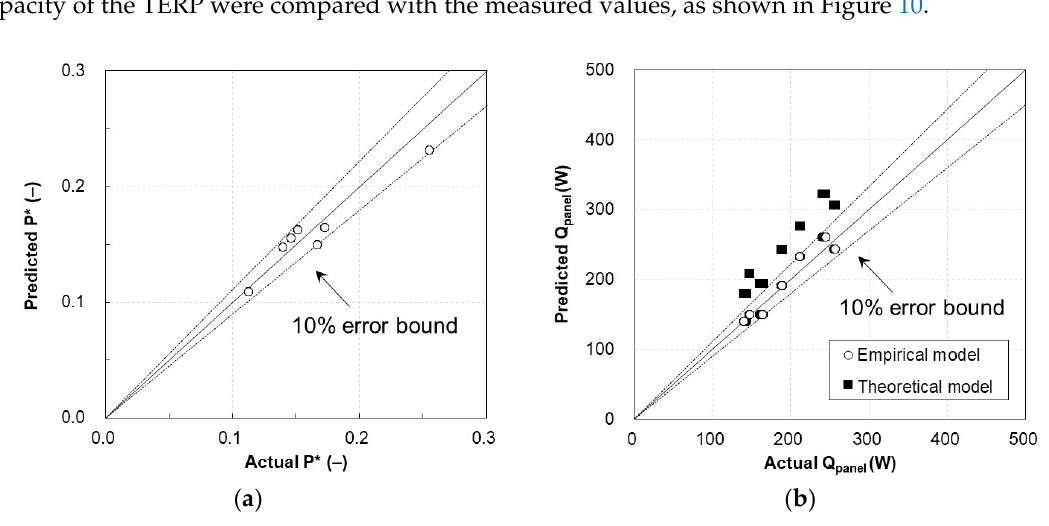
Table 7. Experiments cases for model validation.